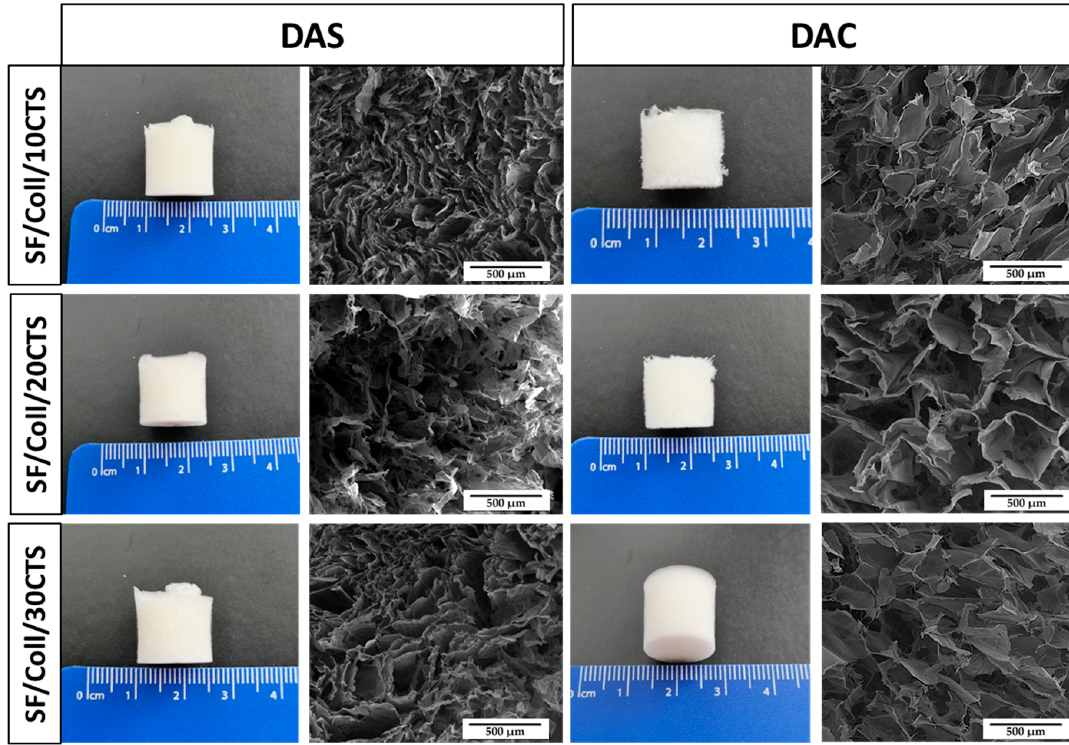
Figure 9. Macroscopic appearance and SEM micrographs of 50/50 SF/Coll scaffolds with 10, 20 and 30% addition of chitosan cross-linked with dialdehyde starch (DAS) and dialdehyde chitosan (DAC).